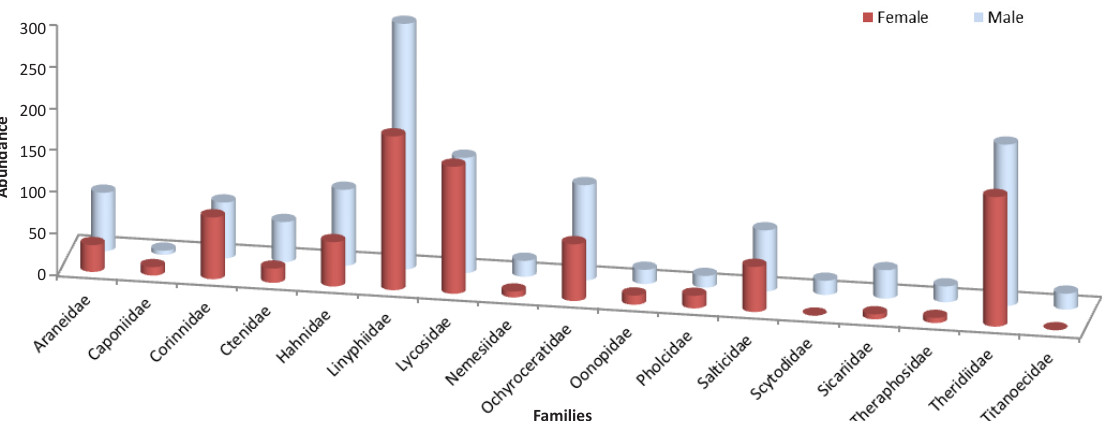
Figure 6. Spider abundance of males and females from 17 families with the highest number of adults collected in the Ecological Park Centennial Jatoba. (U=102; P=0.07)